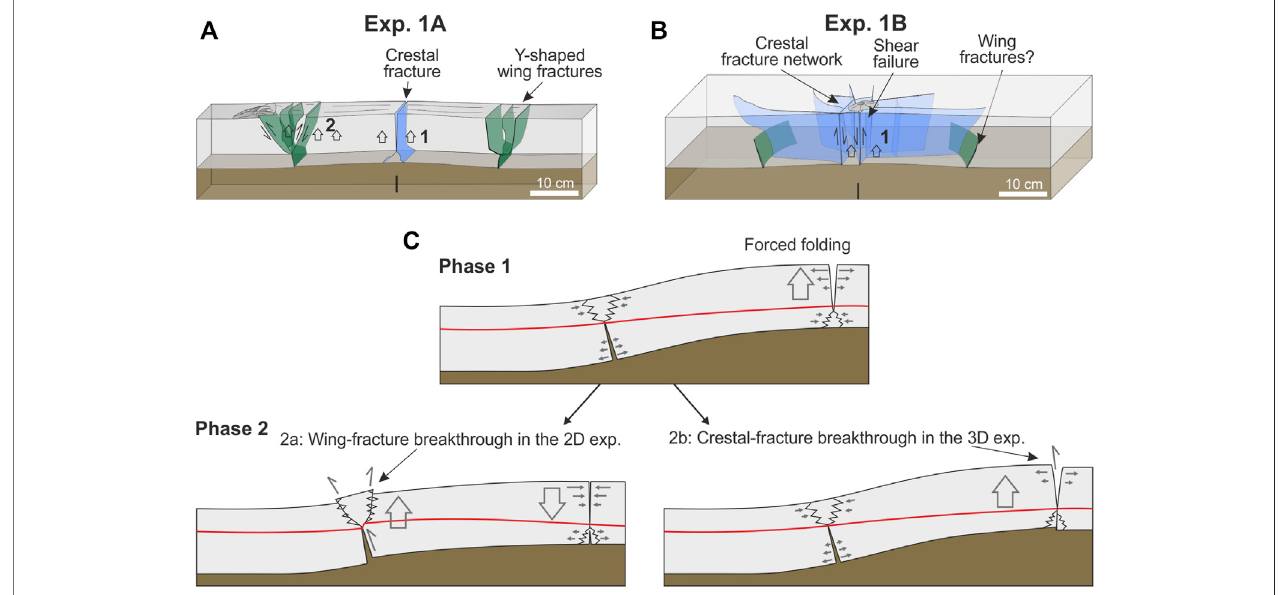
FIGURE 12 | Interpretive sketches showing wing fractures (green) and crestal fractures (blue). For the 3D experiment 1B, the half-width of the box is shown. (A) Exp.1A: Breakthrough occurred along wing fractures. (B) Exp.1B: breakthrough of fractures occurred at the crest of the forced fold. Note that wing fractures did not penetratedtothesurfacesothattheirpositionandshapeisspeculative. (C) Two-stageevolutionofprincipalfractureevolutionshownforthelefthalfofthemodel.Phase 1: Forced foldingofthe cohesive coverlayercaused tensile fracturing at thecrest and thelower fl anks ofthefold.Phase2:shearfailureleadtobreakthrough ofthe fractures. 2a: Wing-fracture breakthrough, 2b: Crestal fracture breakthrough. Thered linedenotes the neutral plane, where normal strains are zero (Bureau et al.,2014).